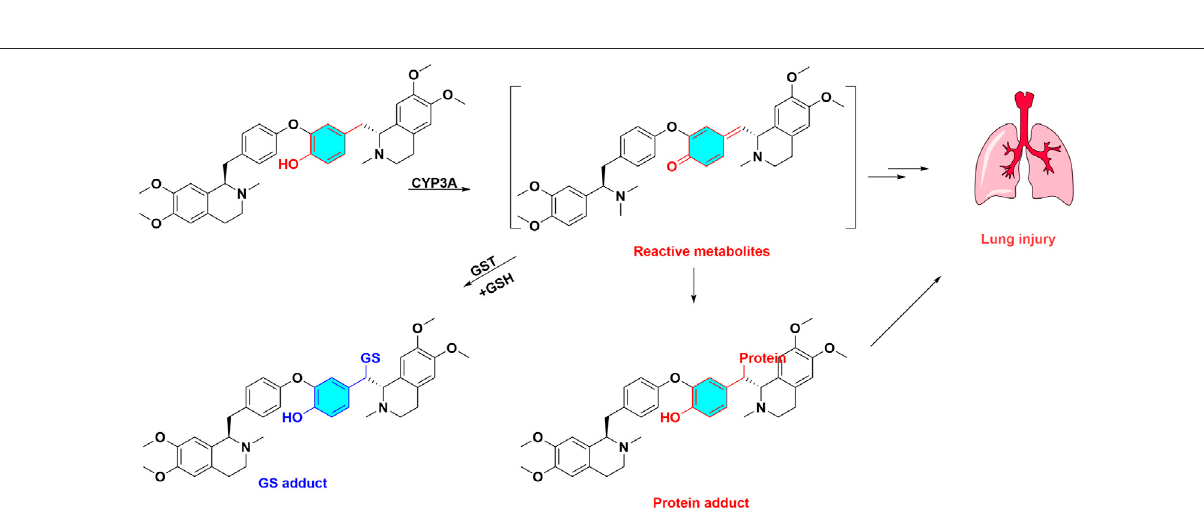
Frontiers in Pharmacology |